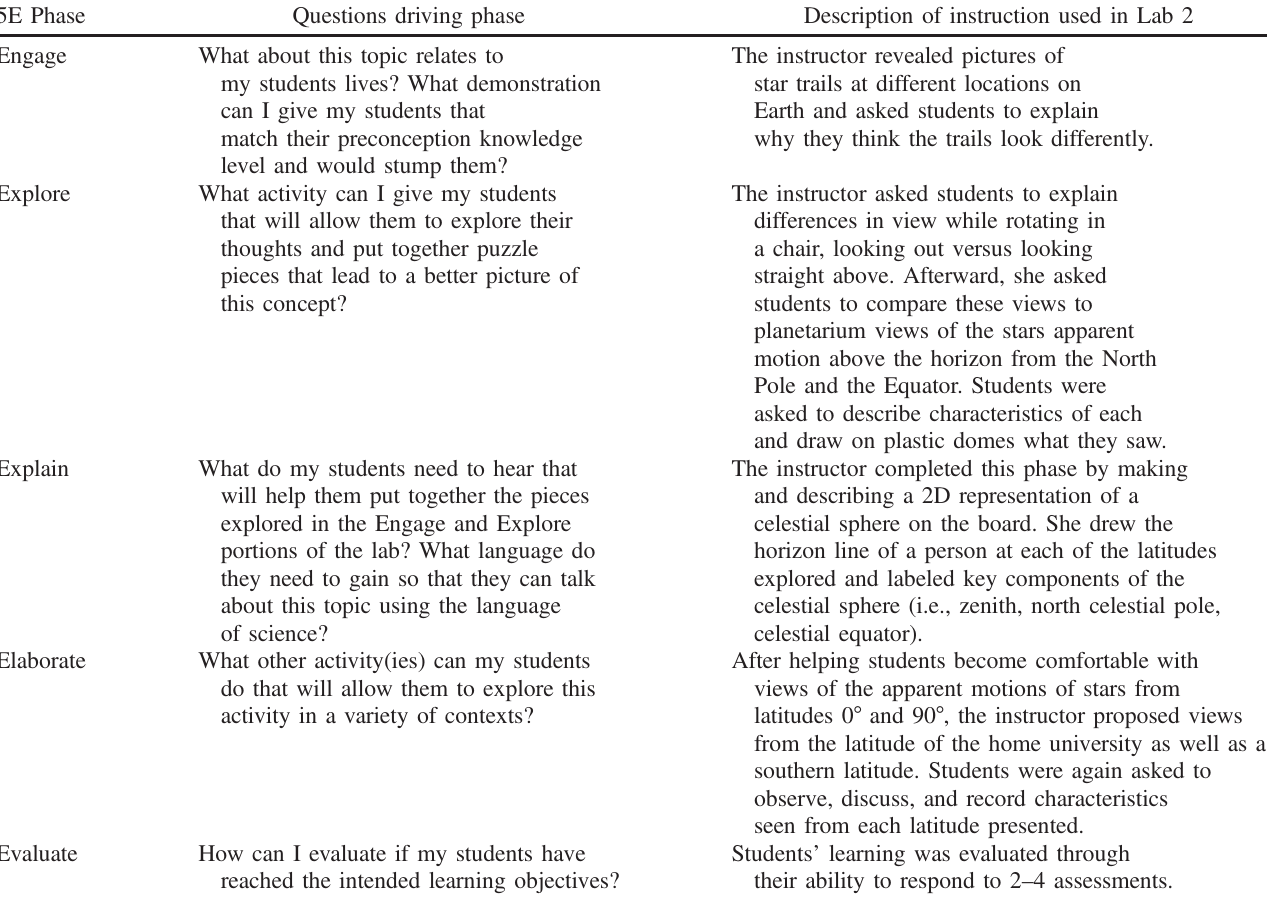
TABLE X. The 5E model phases with examples of questions guiding each phase, and example activities used for each phase during Lab 2 of the introductory astronomy laboratory curriculum described in this